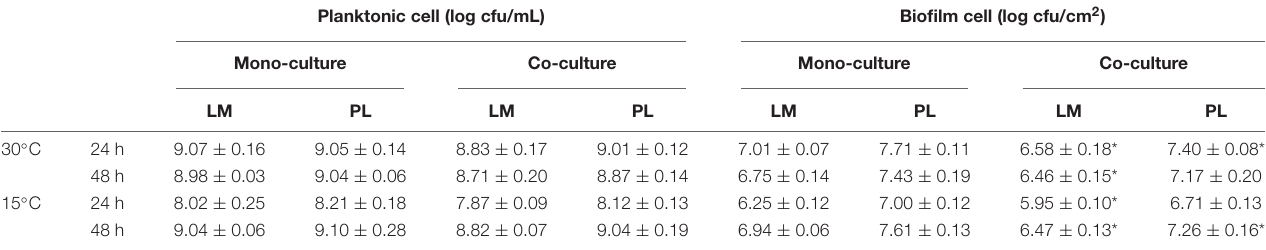
TABLE 1 | Planktonic cell and biofilm cell of L. monocytogenes and P. lundensis in mono-culture and co-culture at 30 and 15 ◦ C on stainless steel coupons. Planktonic cell (log